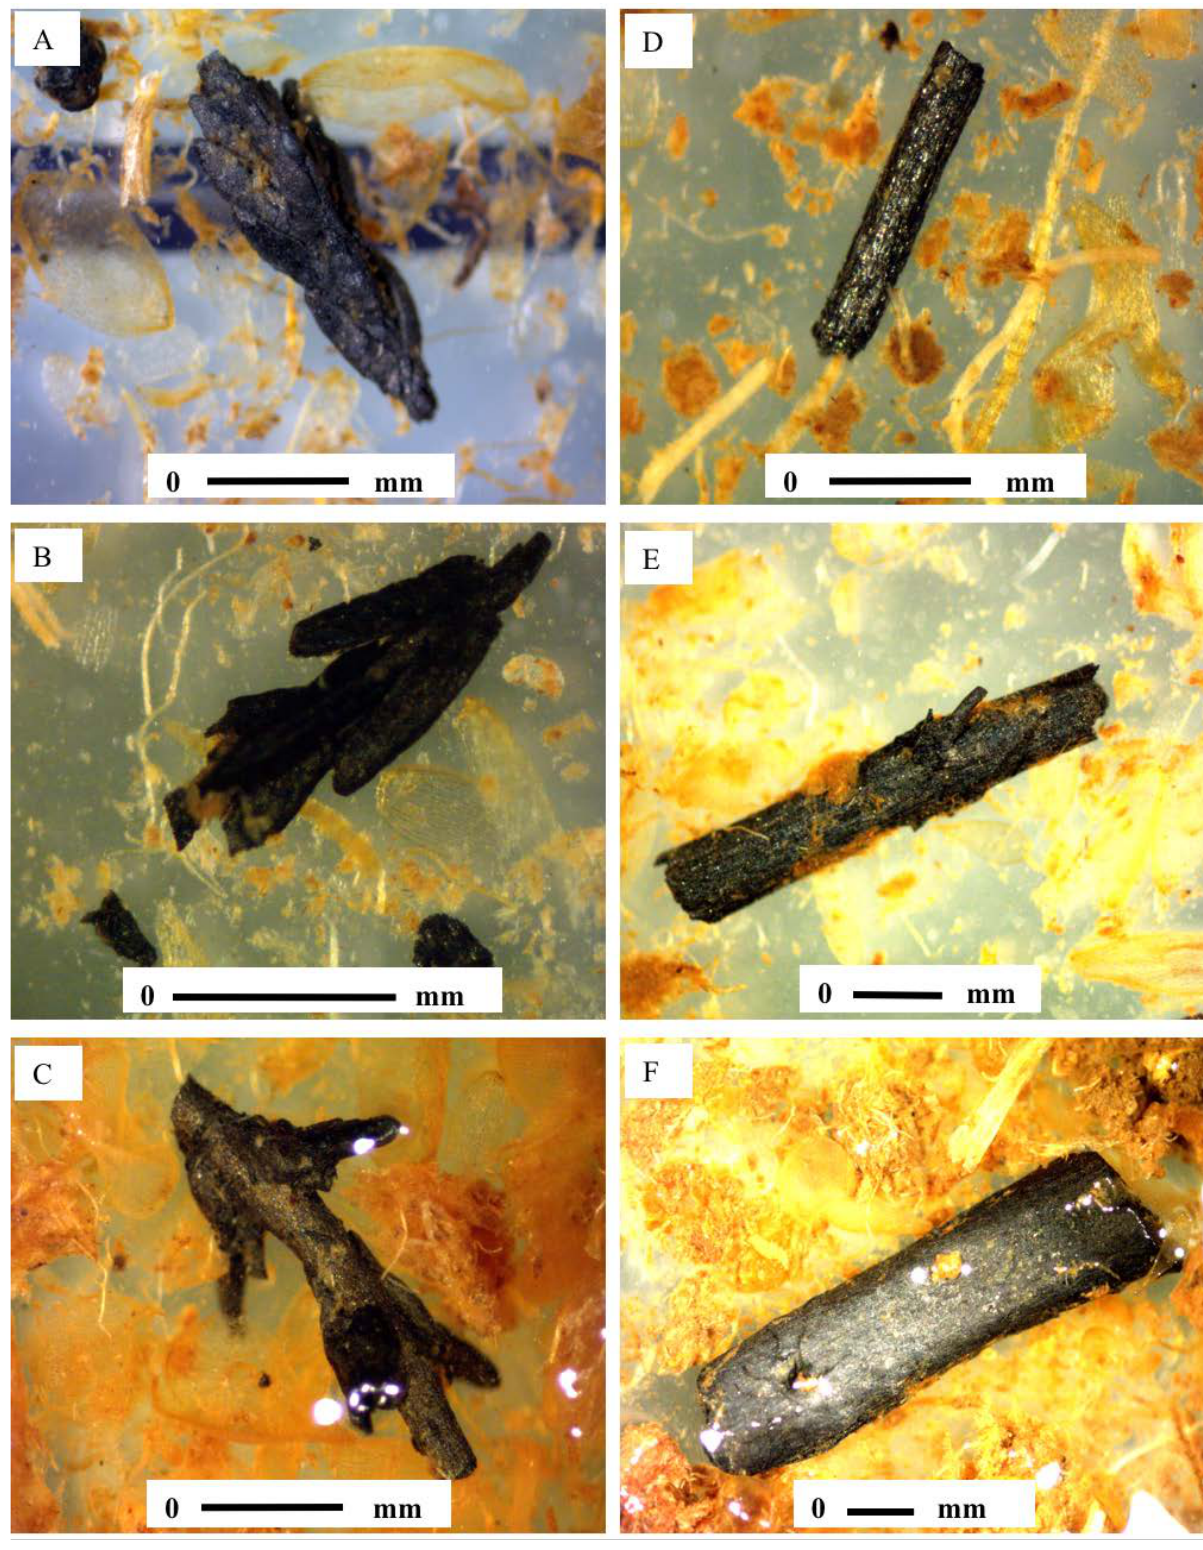
Figure 2. Charcoal from the All Saints Bog core. A–C: charred Calluna fragments; D–F: charred wood. Depths at which they were found: A) 120–130cm, B) 30–40cm, C) 100–110cm, D) 70–80cm, E) 100– 110cm, F)